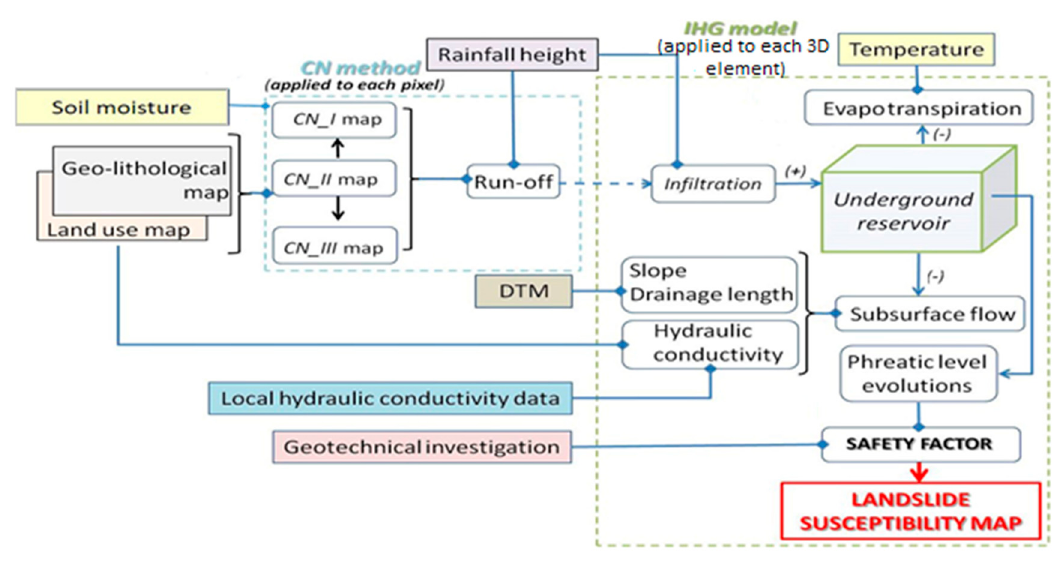
Figure 2. Flow chart of the IHG model.